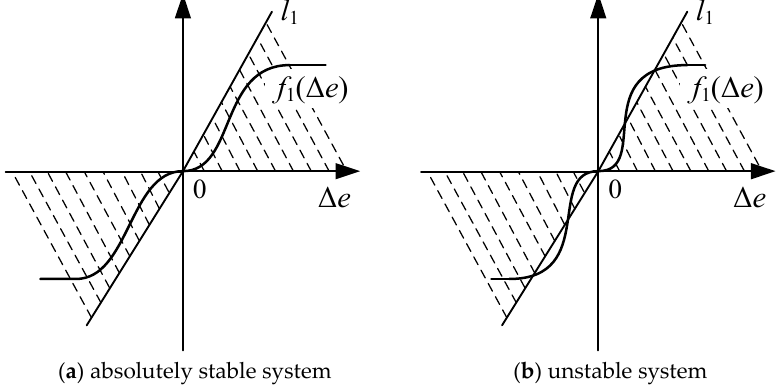
Figure 6. Relation between the nonlinear characteristic curve of the position closed-loop system and l 1 . K ( ) G s and q 3